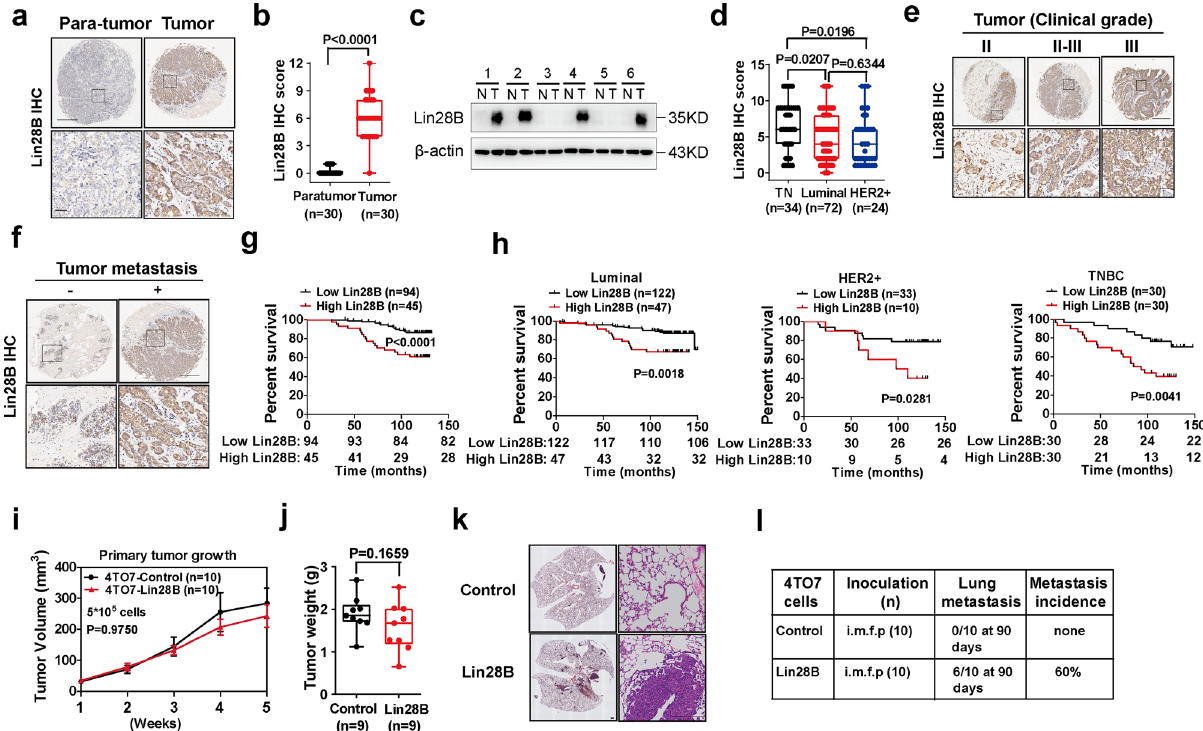
Fig. 1 Lin28B is upregulated in human breast cancer tissues and its overexpression promotes mouse breast cancer lung metastasis. a Representative IHC staining of Lin28B in Cohort I TMA. Scale bars: 200 μ m. IHC immunohistochemistry. b IHC score of Lin28B as in panel a . c Representative western blotting for Lin28B expression in pairs of tumor and para-tumor tissues from patients with breast cancer. β -actin served as a loading control. T tumor; N para-tumor. d IHC score of Lin28B strati fi ed by breast cancer subtypes in Cohort II TMA. TN triple-negative subtype. e IHC staining of Lin28B in different clinical stages of breast tumors. Scale bars: 200 μ m. f IHC staining of Lin28B in breast tumors with different metastatic abilities. Scale bars: 200 μ m. g Kaplan – Meier survival plot of breast cancer patients based on Lin28B expression in TMA Cohort II. h Kaplan – Meier survival plot of breast cancer patients of different subtypes based on Lin28B expression in TMA Cohort II and III. i The graphs showed the measured tumor volumes in mice inoculated with indicated cells ( n = 10). j A similar experiment to panel i . Tumor weights are shown ( n = 9). k , l Representative H&E stained sections of lung metastasis and metastasis incidence summary in mice from experiments in g . Scale bars: 200 μ m. In i , data were presented as mean ± SEM. A two-sided log-rank test was used for statistical analysis of ( g ) and ( h ), one-way ANOVA for ( b ) and ( d ), and two-way ANOVA for ( i ), followed by multiple comparisons, two- tailed Student ’ s t -test for ( j ). For panels ( b ), ( d ), and ( j ), boxes represent data within the 25th to 75th percentiles. Whiskers depict the range of all data points. Horizontal lines within boxes represent mean values. For panels ( e ) and ( f ), experiments were repeated three times independently with similar results; data from one representative experiment are shown. Source data are provided as a Source Data fi (Supplementary Fig. 1o). Limiting dilution assays con fi rmed the increased in vivo tumorigenic capacity of Lin28B-expressing 4TO7 tumors (Supplementary Fig. 1p), suggesting that Lin28B facilitates the stem cell properties of breast tumor cells.